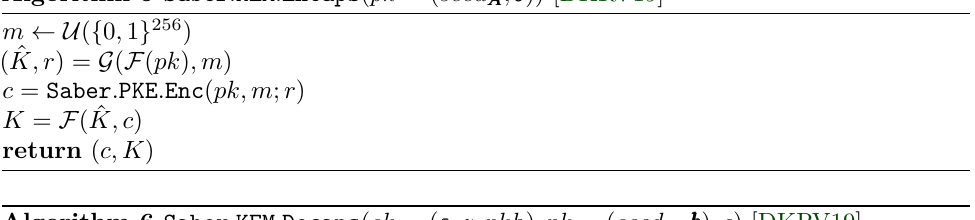
Algorithm 6 Saber . KEM . Decaps ( sk = ( sss, z, pkh ) , pk = ( seed AAA ,bbb ) , c )